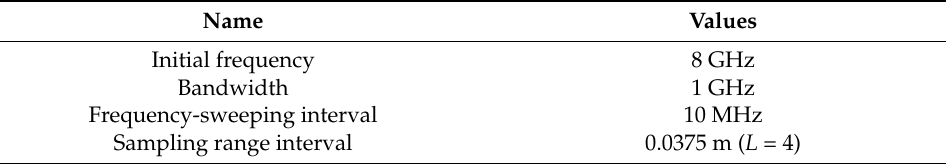
Table 2. Radar system